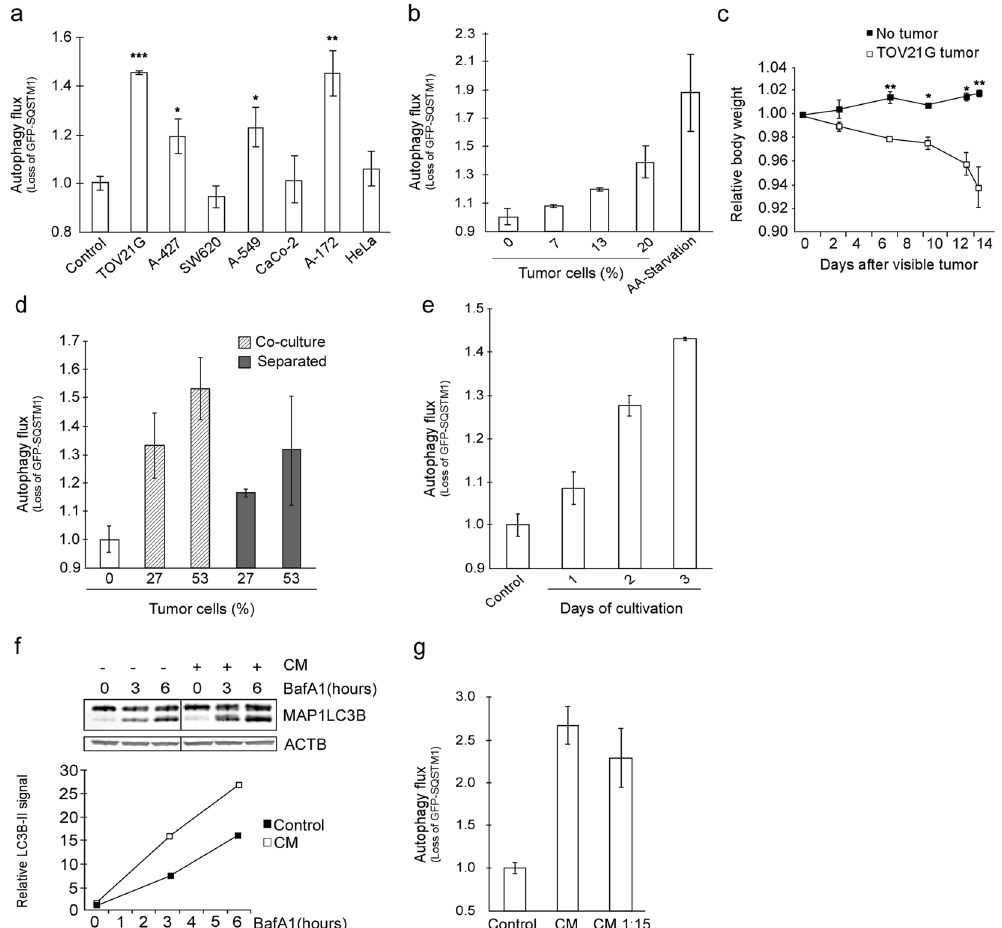
Figure 2. TOV21G cancer cells cause cachexia and secrete autophagy-inducing substances. ( a ) Screen of various cancer cell lines for the ability to induce autophagy in reporter cells (co-cultures). Mean from one experiment using triplicate wells ± SD. * p = 0.04, ** p = 0.02, *** p = 0.008 vs control (Student t-test). ( b ) Reporter cells co-cultured with increasing percentage of TOV21G cells. Amino acid starvation (HBSS, 16 h) as positive control. Mean from one experiment representative of six experiments using duplicate wells ± SD. ( c ) Mean relative body weight (at indicated time intervals) of TOV21G tumor-bearing mice (n = 6) and control mice (n = 6) ± SEM. * p < 0.01, ** p < 0.005 vs no tumor (Student t-test). ( d ) Autophagy flux in reporter cells co- cultured with or separated from TOV21G cells using a semi-permeable membrane. Mean from one experiment using duplicate wells ± SD. ( e ) Autophagy flux in reporter cells after 3 days of exposure to conditioned medium (CM) from TOV21G cells cultured for 1–3 days (n = 1 for 1 day and n > 6 for 3 days). Mean from one representative experiment using duplicate wells ± SD. ( f ) Protein levels of MAP1LC3B in reporter cells treated with CM from TOV21G cells for 3 days with or without BafA1 (100 nM) for indicated time periods. MAPLC3B-II signal is normalized against β -actin/ACTB. The data are representative for two independent experiments. Image, originating from the same blot, is cropped. ( g ) Autophagy flux in reporter cells exposed to diluted (1:15 in complete growth medium) or undiluted CM from TOV21G cells. Mean from one representative of three independent experiments using triplicate wells ±